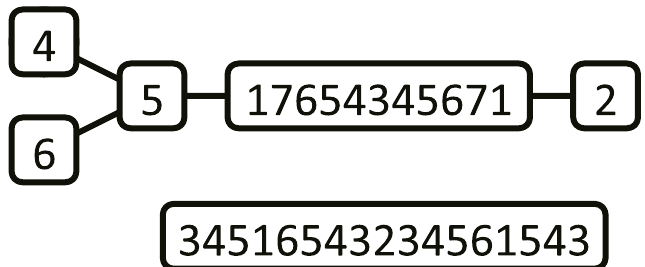
Figure 9 . The Dynkin diagram of the D 5 (cid:2) A 1 subalgebra within the original E 7 algebra, which preserves the (2 ; 1 ; 2 ; 1) model without rank